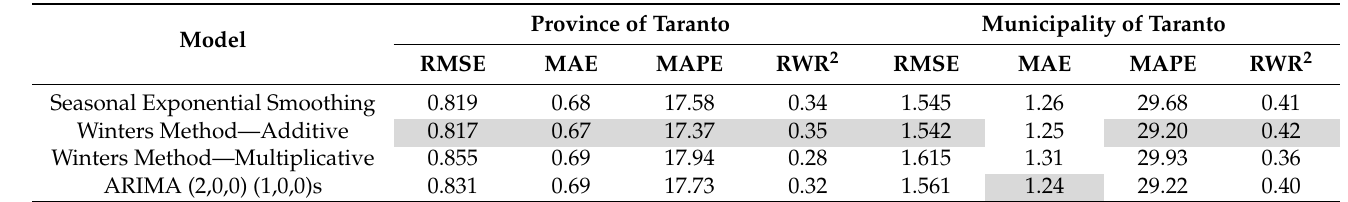
Table 3. Measures of goodness of fi t of forecasting models applied to the series of adjusted mortality rates.